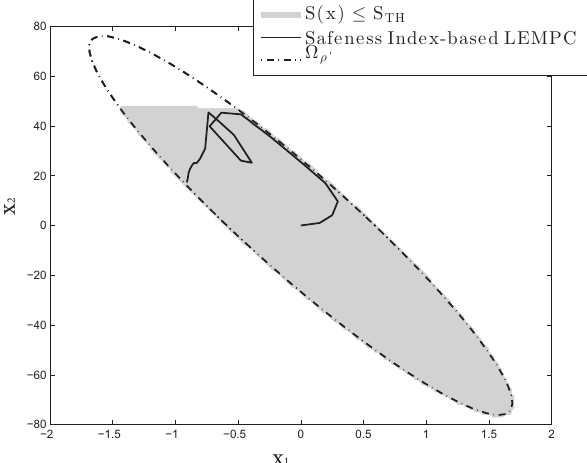
Figure 1. A schematic representing the safe operating region S (the gray region) with an example closed-loop trajectory under the Safeness Index-based Lyapunov-based economic model predictive control (LEMPC) design of Equation (5) for the initial condition (0,0).